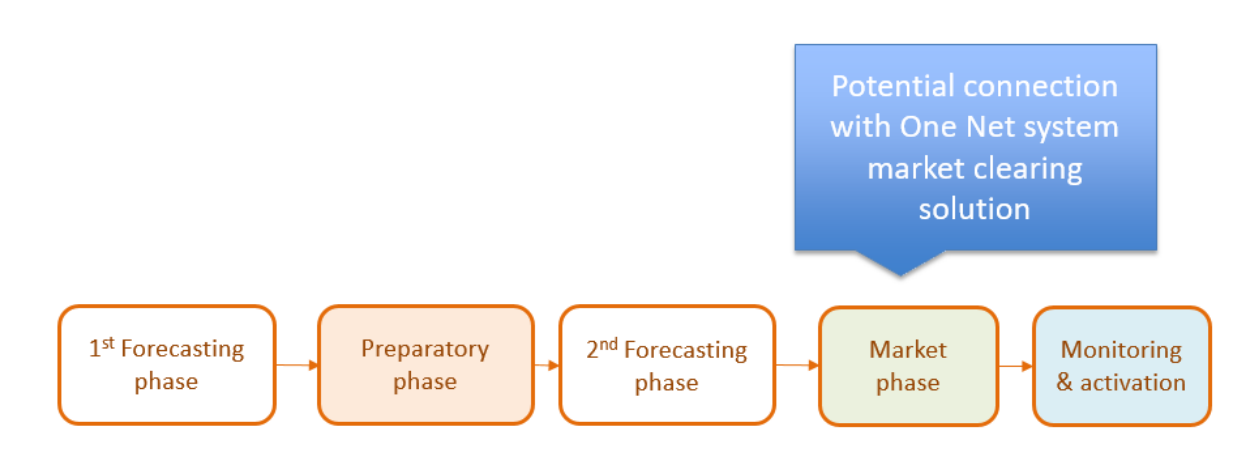
Figure 11. OneNet market clearing solution in F-channel.